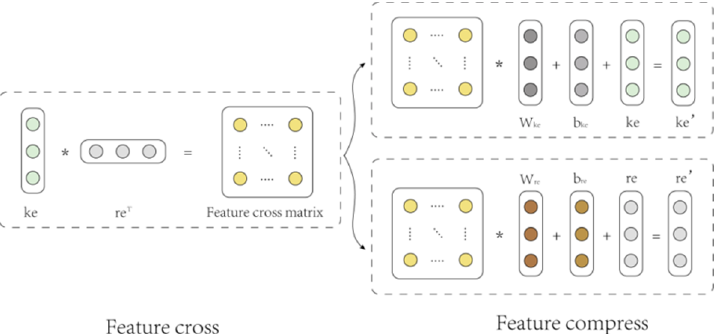
Figure 3. Information Interaction Unit. There are two vectors, ke and re . Feature cross is used to construct a d-dimensional matrix, and W ke and W re map a d-dimensional matrix to a d-dimensional vector.